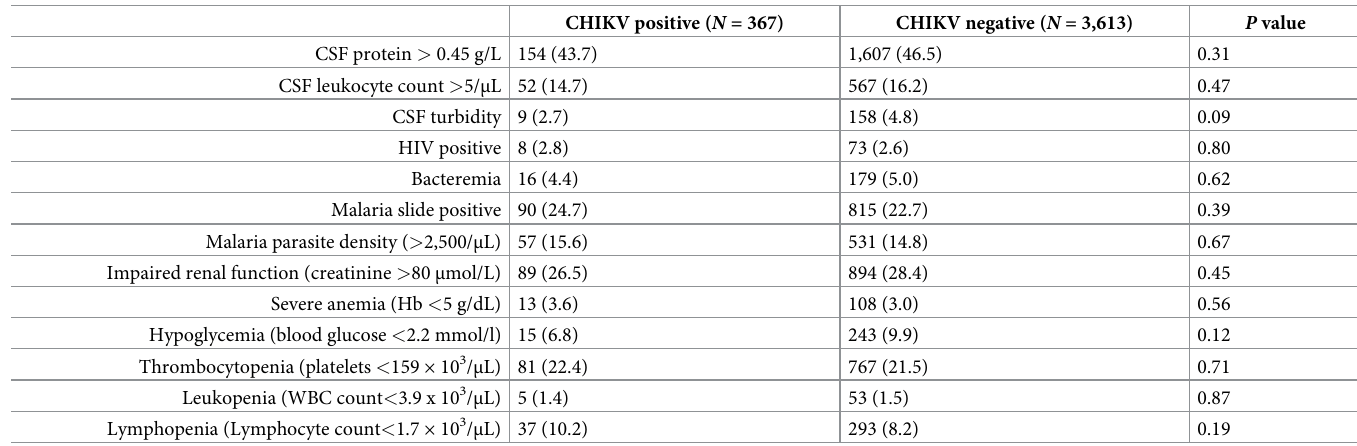
showed no correlation with age (Spearman’s rho = − 0.09, p = 0.07). CHIKV RT-PCR